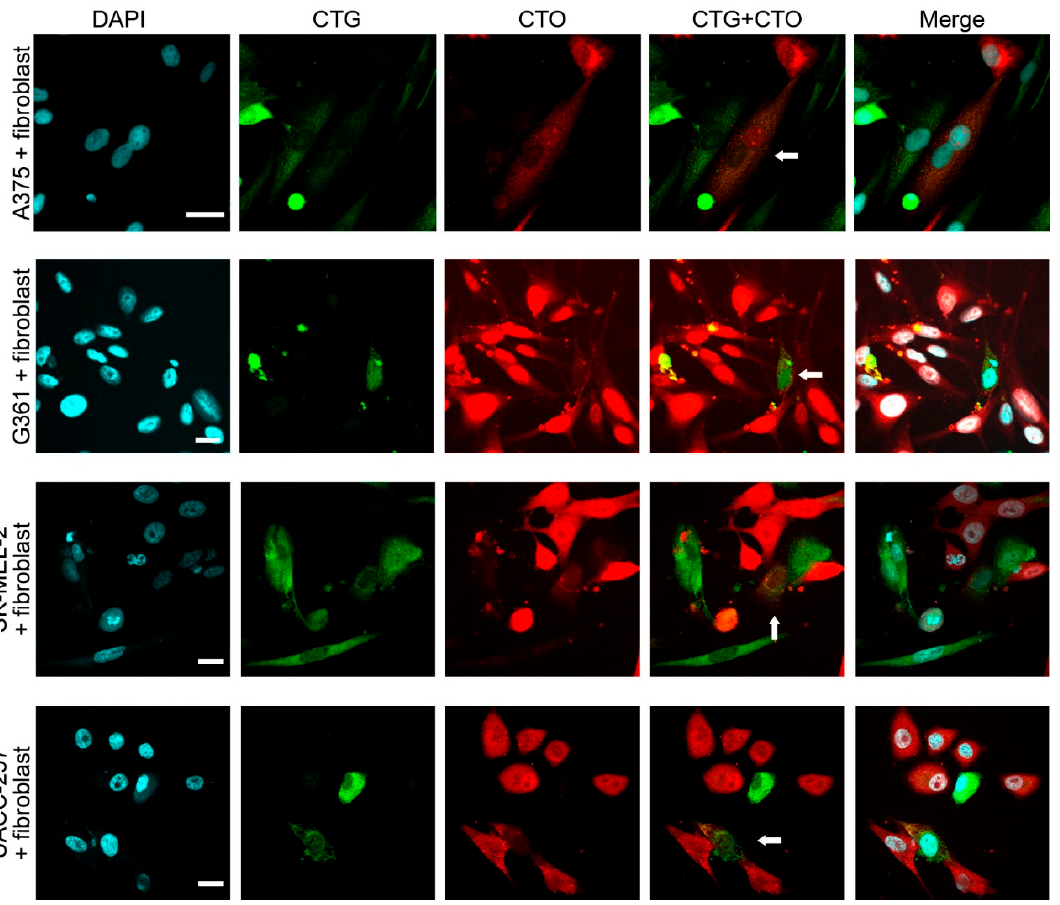
Figure 3. Melanoma–fibroblast hybrids are indistinguishable from stromal cells based on cell morphology. Spontaneously formed melanoma (CTO)–fibroblast (CTG) hybrids (white arrows) from different melanoma cell lines adopt the morphology of fibroblasts. White bars indicate 20 µm.